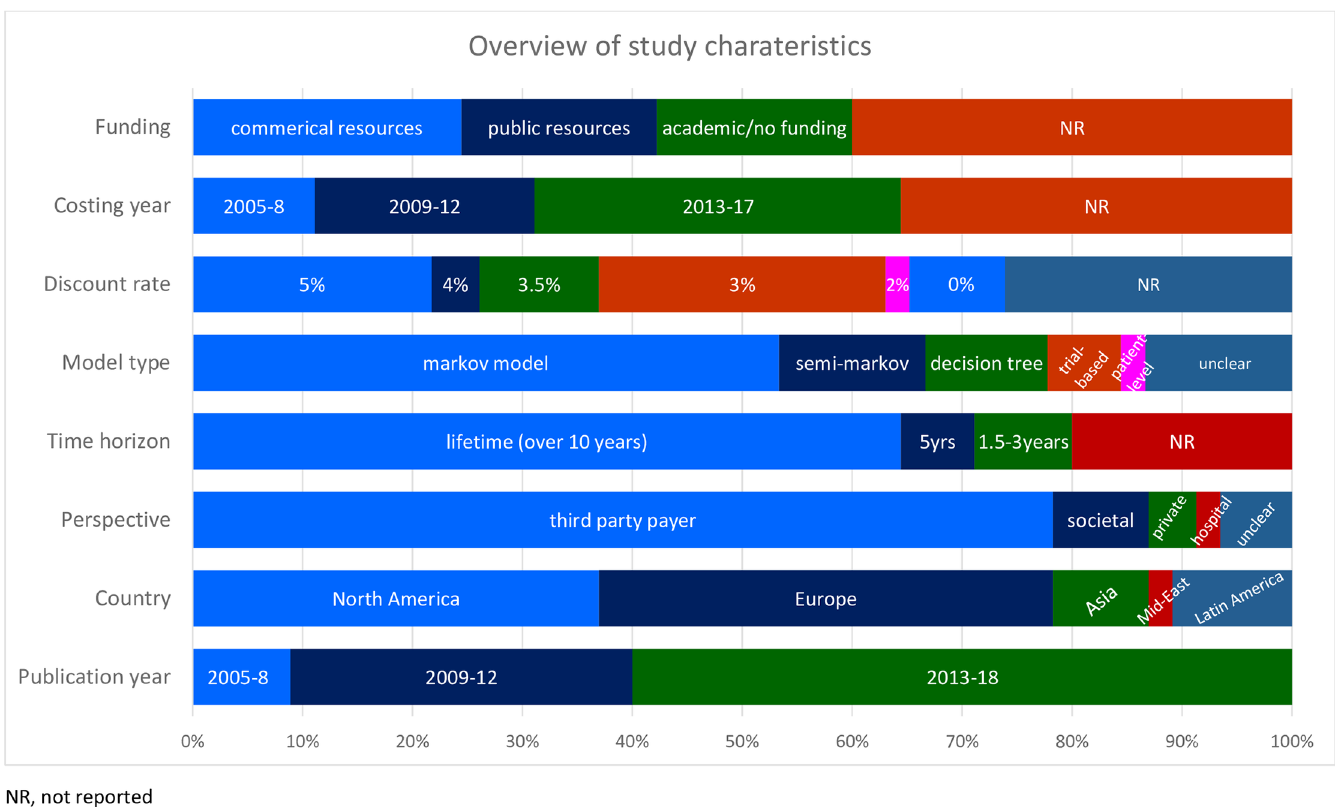
Fig 2. Overview of study